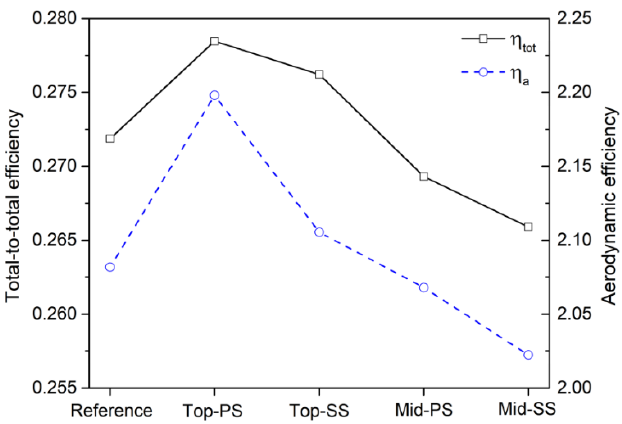
Figure 18. Total-to-total and aerodynamic efficiencies under various blade conditions.